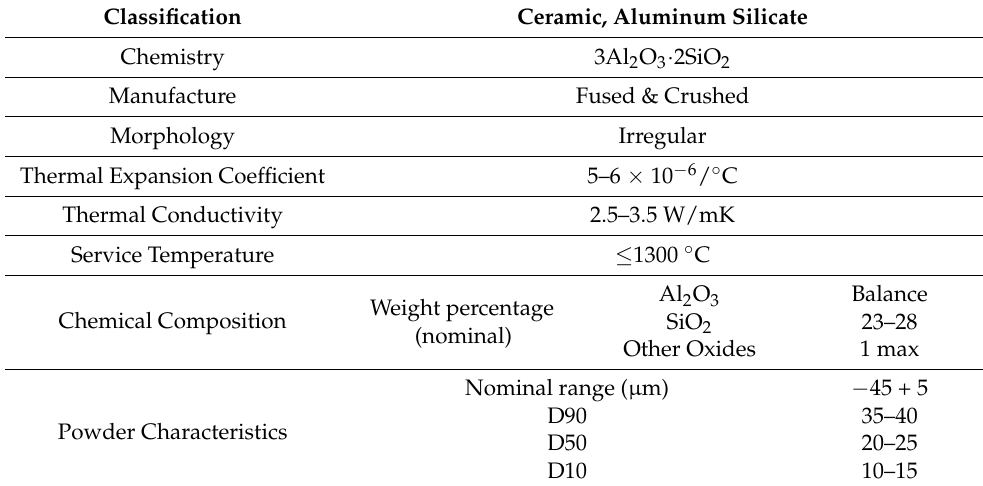
Figure 6. SEM photomicrographs of Al 2 O 3 · SiO 2 microstructure [22]. Table 2. Al 2 O 3. SiO 2 Material (Oerlikon Metco, Shanghai, China) Characteristics.